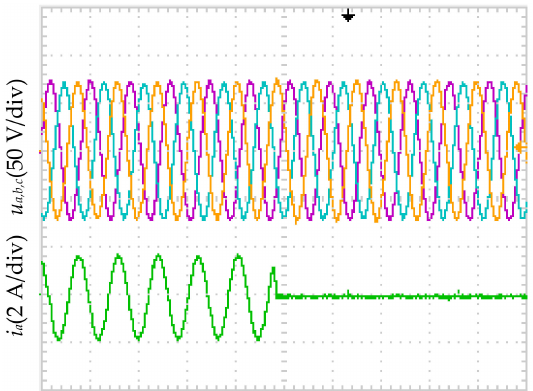
Figure 18. Three-phase output voltages and c-phase current of switching from balanced load to unbalanced